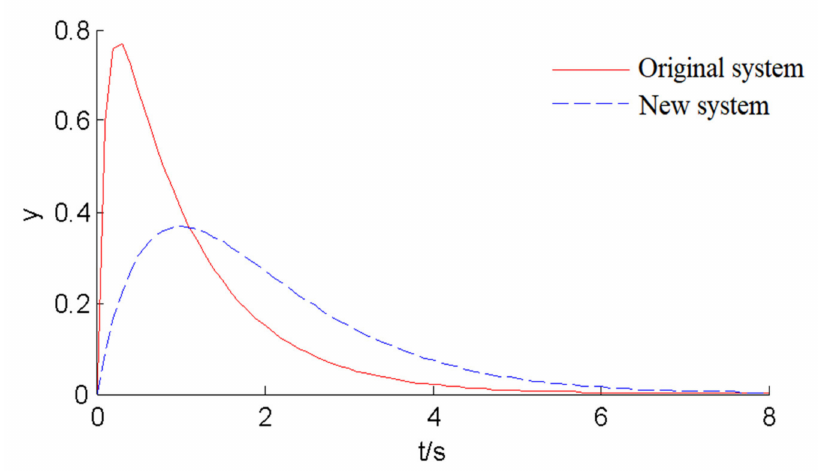
Figure 3. Impulse Response of Two